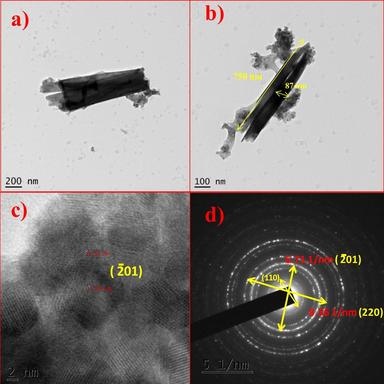
a), b), TEM images c) HR-TEM image d) SAED pattern of IL-β-MNV.